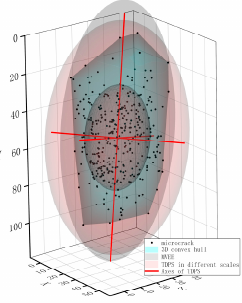
Figure 3. The schematic of three spatial characterization methods. Black dots mark the microcracks, the black ellipsoid represents the space formed by MVEE, the red ellipsoids represent the TDPS space at two different scales, where the three red line segments are the three axes of TDPS, and the cyan irregular geometry is formed by 3D convex hull.